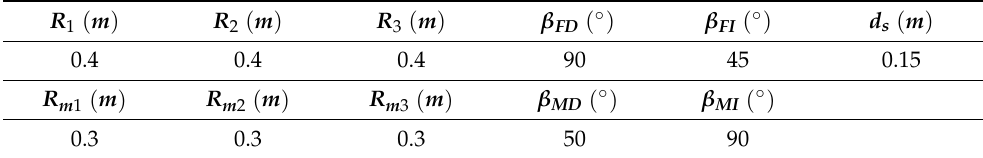
Table 1. Geometric parameters for the 3UPS+RPU